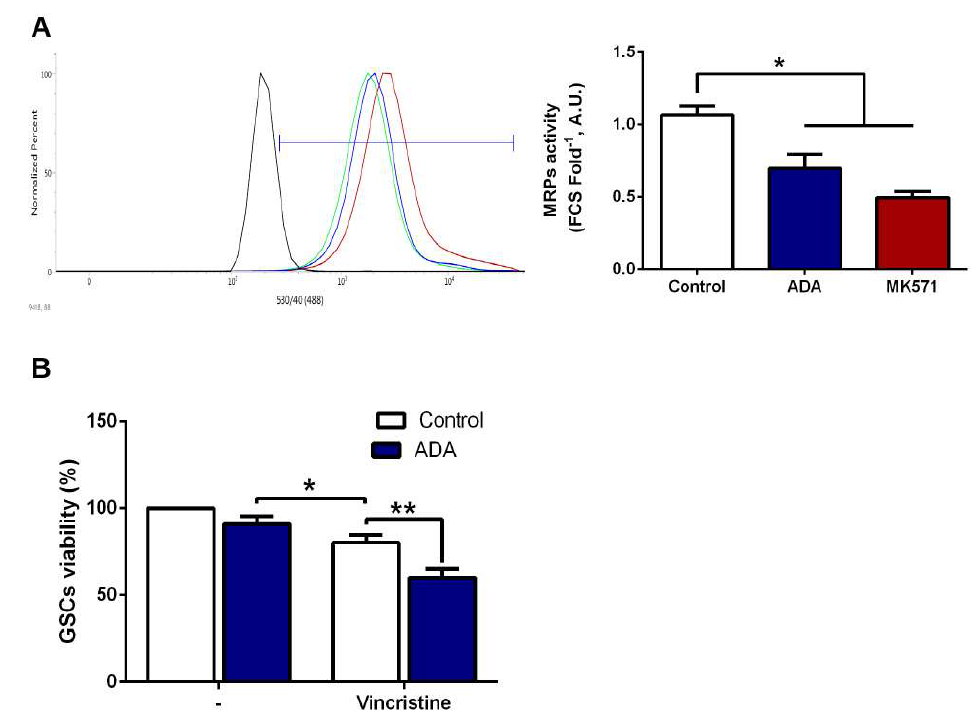
Figure 5. Effects of adenosine depletion on MRPs-mediated chemoresistance. ( A ) MRPs activity was